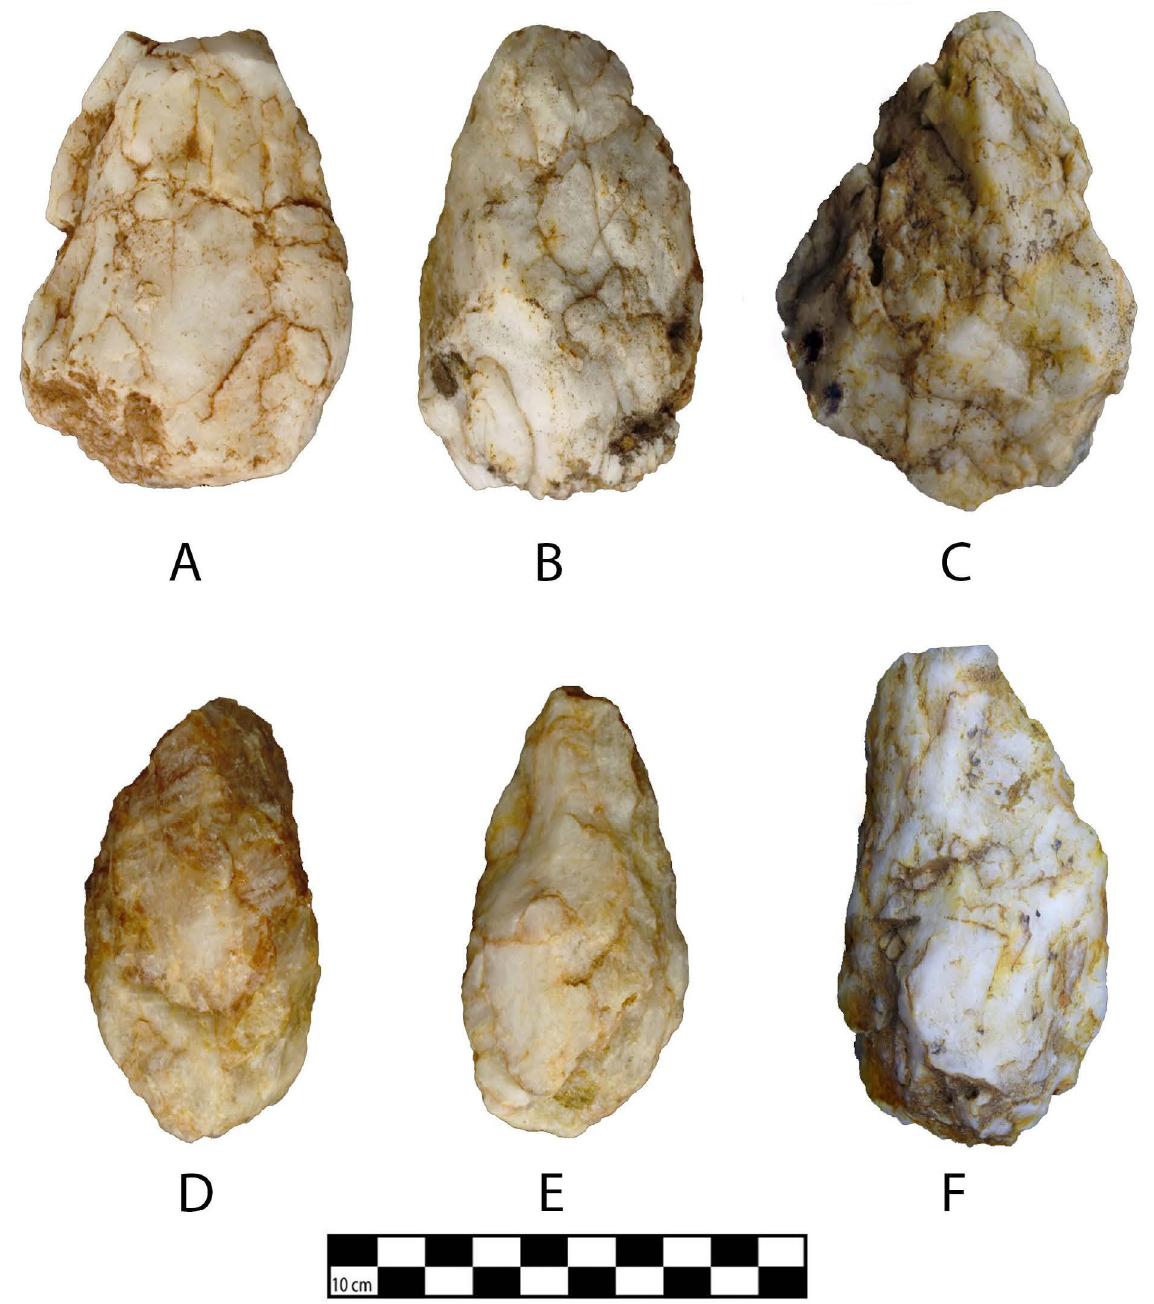
Figure 3. (A - F) A selection of handaxes (bifaces). The raw material is